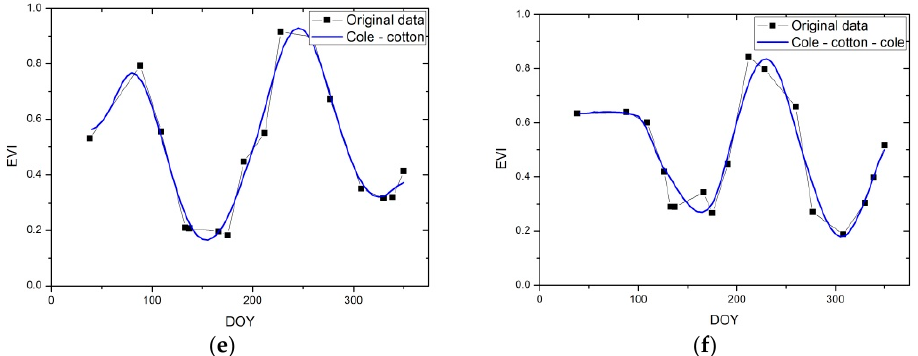
Figure 8. Typical agricultural farming patterns in Lixian.